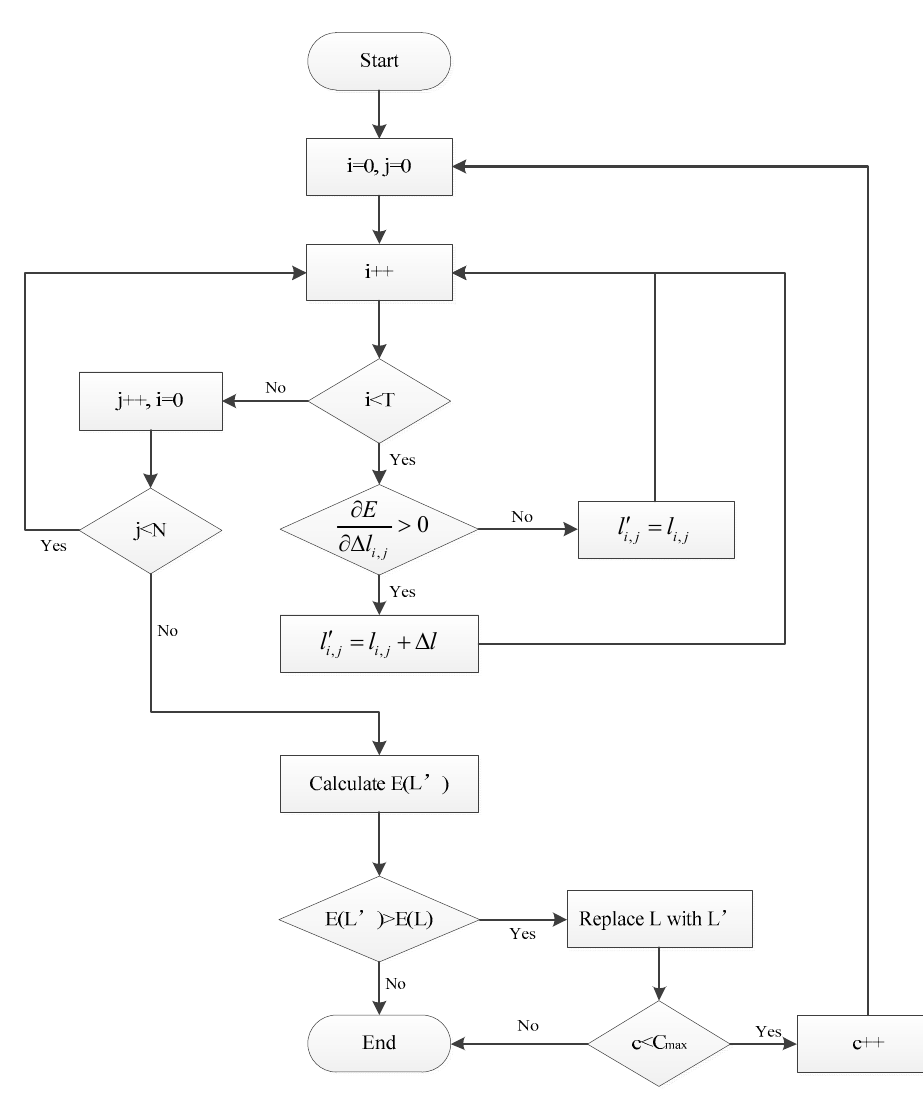
Figure 4. Flowchart of gradient ‐ based search strategy.